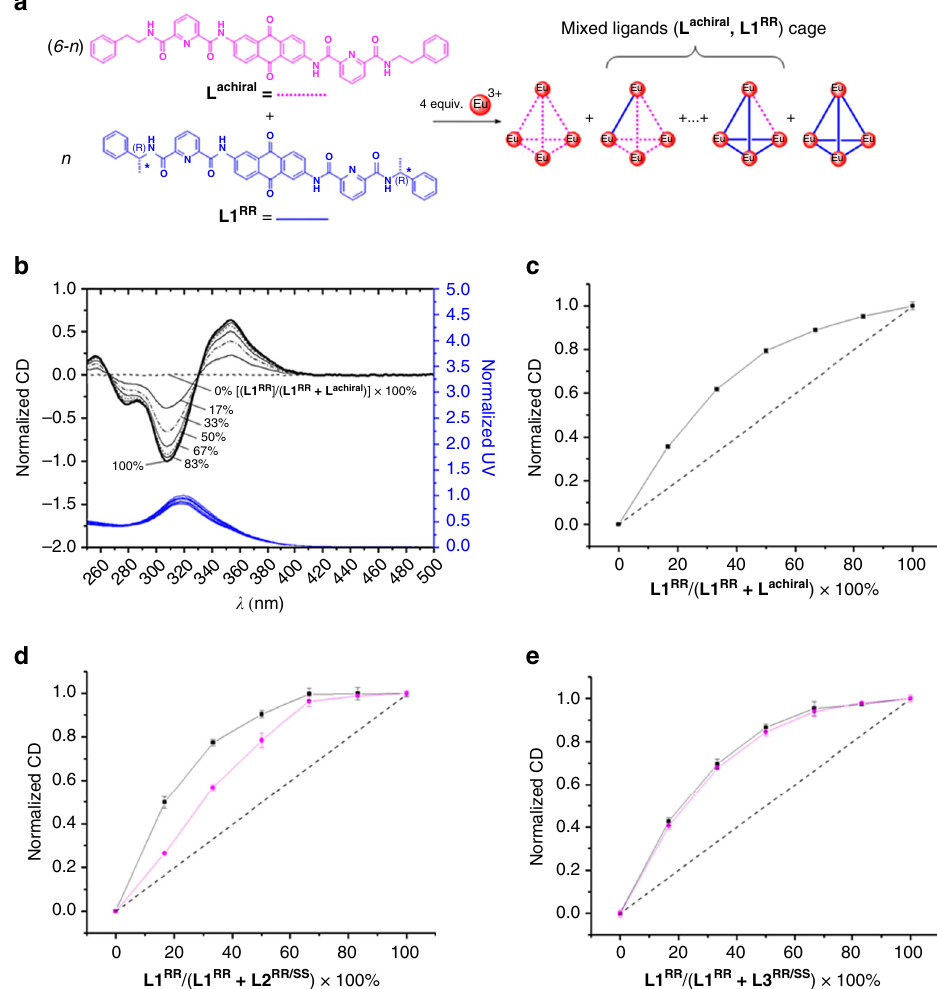
Fig. 3 Chiral ampli fi cation experiments. The chiral ampli fi cation experiments of L achiral , L2 RR/SS or L3 RR/SS (soldiers) were performed with L1 RR (sergeant). a Schematic diagram of chiral ampli fi cation experiment of tetrahedral cage, [( L1 RR ) n ( L achiral ) 6 ─ n Eu 4 (OTf) 12 ], ( n = 0 ─ 6), using L achiral and L1 RR . b Normalized CD (top) and normalized UV – Vis absorption spectra (bottom) of the supramolecular tetrahedral cage [( L1 RR ) n ( L achiral ) 6 ─ n Eu 4 (OTf) 12 ], ( n = 0 ─ 6) in CH 2 Cl 2 /MeOH/MeCN (73:3:24, v/v/v) by maintaining 2.05 × 10 − 5 M of [( L1 RR ) n ( L achiral ) 6- n ]Eu 4 (OTf) 12 ], ( n = 0 ─ 6). c Plots of normalized CD intensities (354 nm) of the supramolecular cage [( L1 RR ) n ( L achiral ) 6 ─ n Eu 4 (OTf) 12 ] ( n = 0 ─ 6) as a function of % L1 RR . Error bars are standard errors of the means (s.e.m.). Performed in triplicate. d Plots of normalized CD intensities (354 nm) for [( L1 RR ) n ( L2 RR/SS ) 6 ─ n Eu 4 (OTf) 12 ] ( n = 0 ─ 6), (square: L2 RR , circle: L2 SS ) as a function of % L1 RR . Error bars are s.e.m. Performed in triplicate. e Plots of normalized CD intensities (354 nm) for [( L1 RR ) n ( L3 RR/